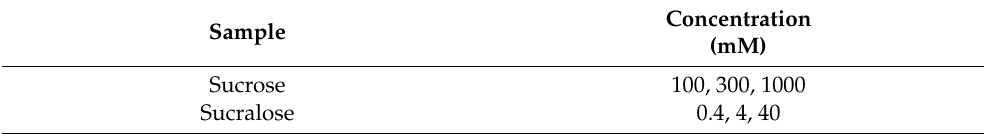
Table 1. Concentration of sucrose and sucralose.